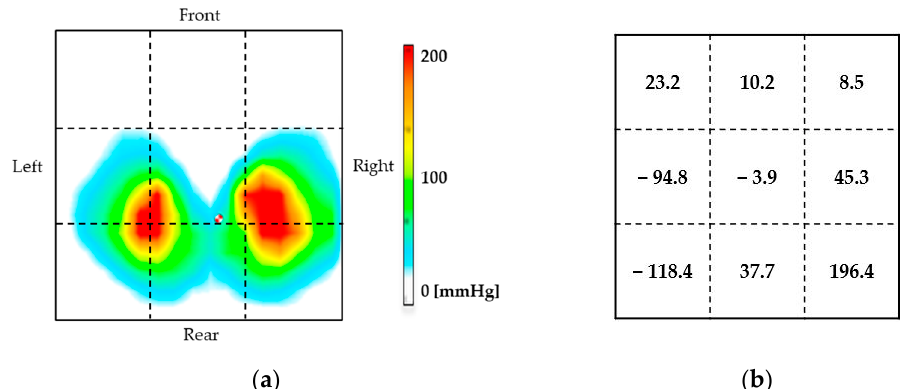
Figure 10. Different seat pressure distribution values for the nine segments: ( a ) an example of a heat map at rest, ( b ) the difference results for seat pressure distribution.